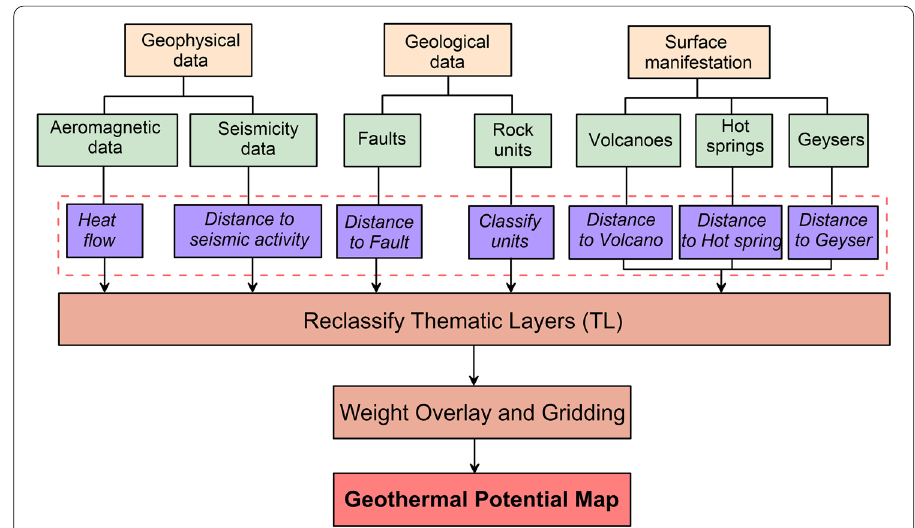
Fig. 2 Flowchart of the approach utilized to produce a geothermal potential map of Africa continent. Digitally processed data included five thematic layers: surface manifestations (hot springs, volcanoes, geysers), geologic units, proximity to fault lines, seismic epicenters, and heat flow (derived from aeromagnetic